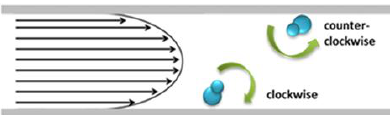
Figure 1. The cartoon explains the rotation effect induced by the parabolic velocity profile, when objects are close to the channel walls.